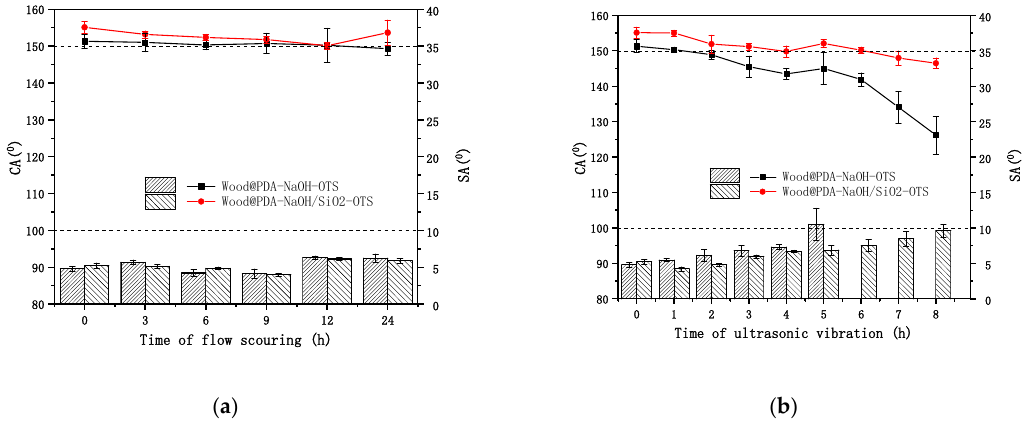
Figure 7. CAs (in lines) and SAs (in bars) of superhydrophobic wood under ( a ) flow scouring and ( b ) ultrasonic vibration.